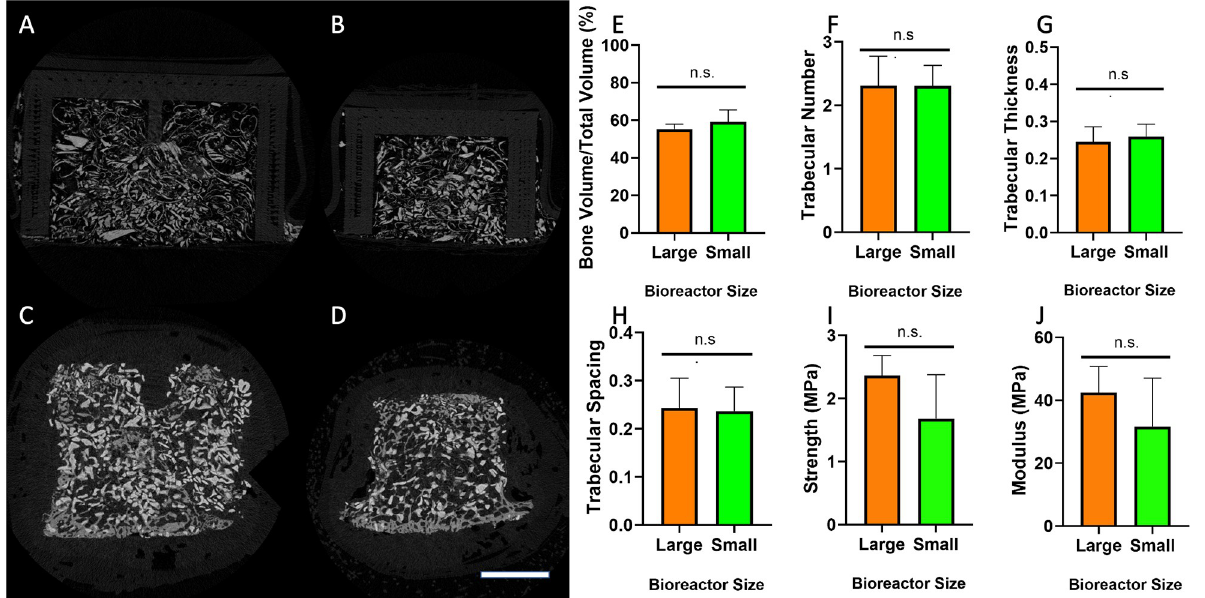
Fig 5. Bioreactor tissue analysis. Representative microCT images of bioreactor tissues from large (A,C) and small (B,D) bioreactors prior to implantation (A,B) and after 9 weeks implantation (C,D); Scale bar: 500 μ m. Radiographic analysis of tissue in the large and small bioreactors after 9 weeks of implantation showing BV/TV (E), TbN (F), TbTh (G), and TbSp (H). Mechanical analysis of specimens allowed for the calculation of compressive modulus (I) and compressive strength (J) were calculated for bioreactor tissue harvested at 9 weeks. (n.s. = not significant, p > 0.05).